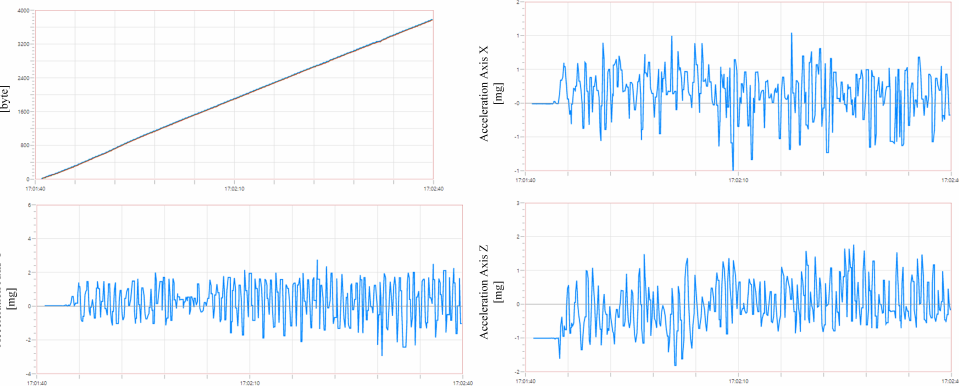
Figure 9. The figure shows a graph (left corner) generated in Thingworx to represent the amount of received data from the embedded system in time. The other graphs show acceleration data in the x , y and z axes.